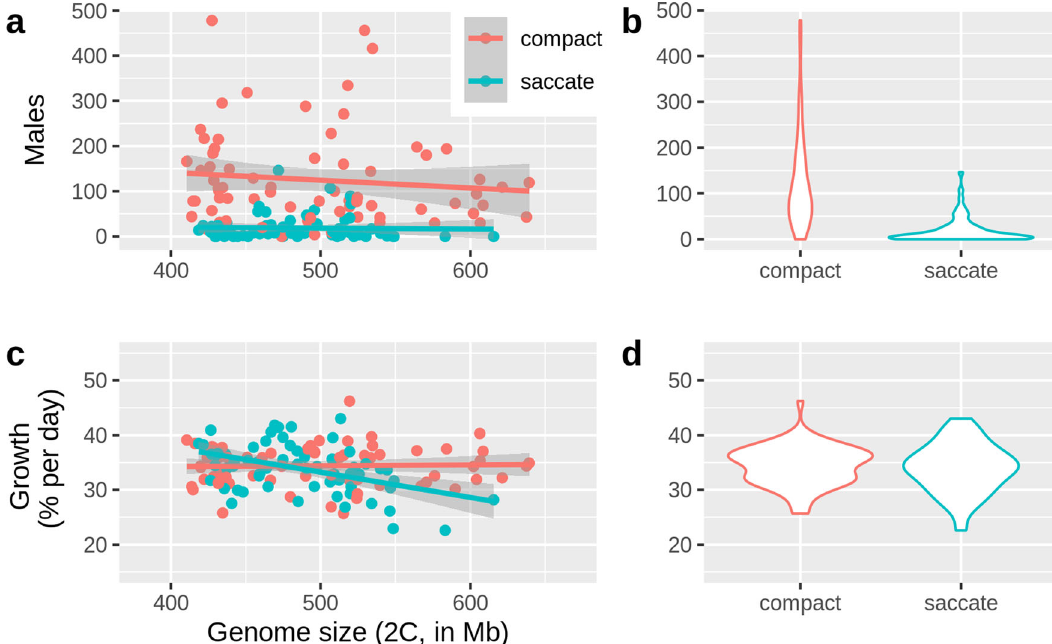
Fig. 3 Relationships between genome size and morphotype on sexual propensity and population growth rate. a Sexual propensity (number of males produced in dense clonal cultures) was not signi fi cantly correlated with genome size ( n = 141 clones); b Morphotypes differed in sexual propensity, as the compact morph produced signi fi cantly more males than the saccate morph ( p < 0.001, Supplementary Table 2); c Population growth rates were signi fi cantly reduced at higher genome sizes in the saccate morph ( p < 0.05, Supplementary Table 3). d The two morphotypes did not differ in growth rate. Source data of this fi gure are provided in Supplementary Data